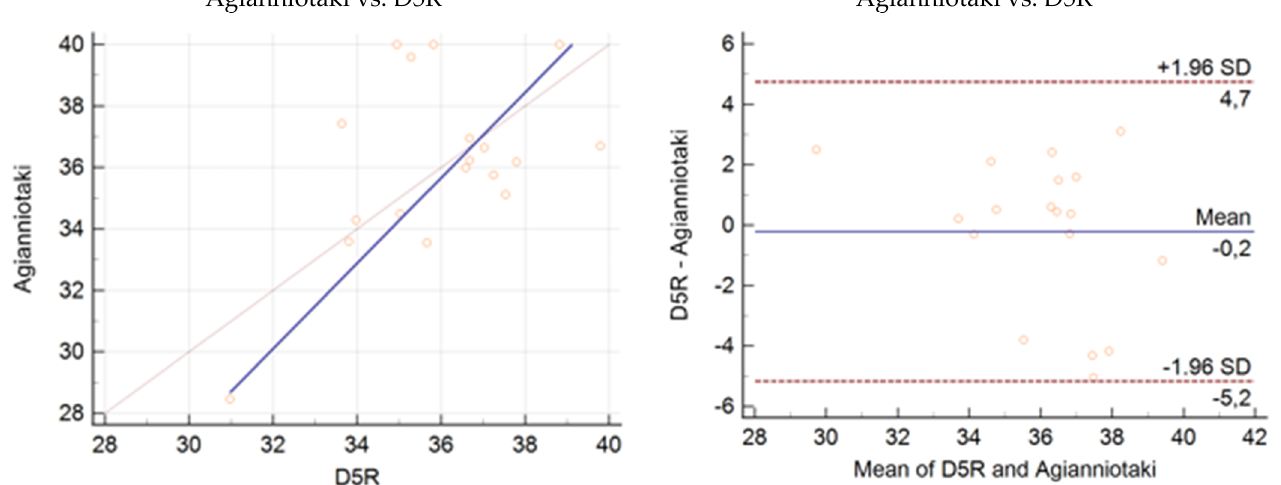
Figure 4. ( a ) Passing–Bablok regression plot: comparison of Ct values obtained with the wild-type Agianniotaki strain assay vs. Capripox-specific real-time PCR D5R assay, with 95% CI in 18 samples. ( b ) Bland–Altman plot: comparison of Ct values obtained with the wild-type Agianniotaki strain assay vs. Capripox-specific real-time PCR D5R assay, with 95% CI in 18 samples.